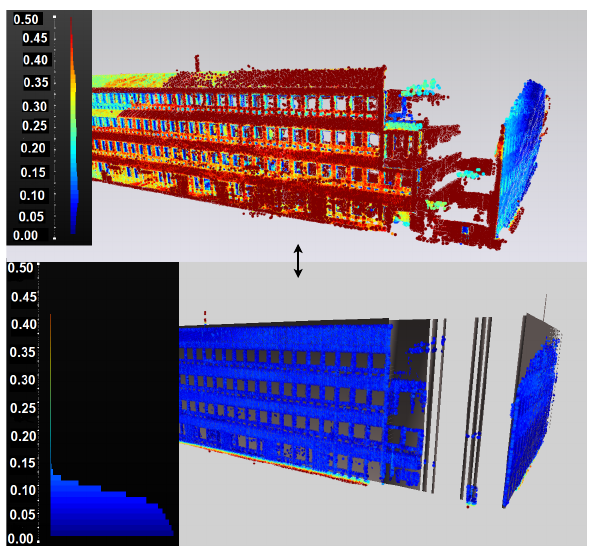
Figure 11. Raw (above) and P high (below) fusion sets with deviations obtained by Hausdorff metric given in